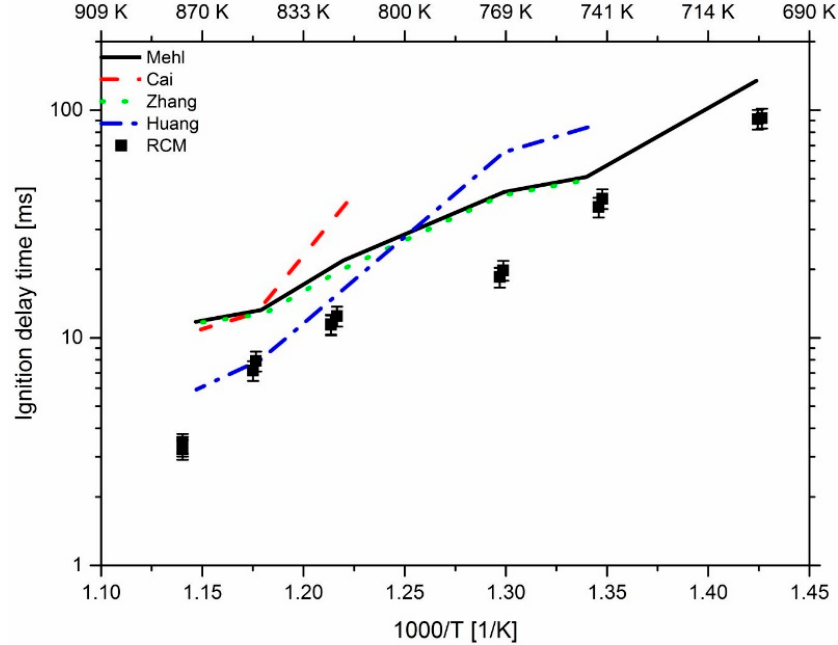
Figure 9. Experimental RCM data (symbols) versus model prediction at P c = 60 bar using 95 mol % CH 4 , 5 mol % C 3 H 8 , and x n-C = 0.025 at λ global = 1.685.